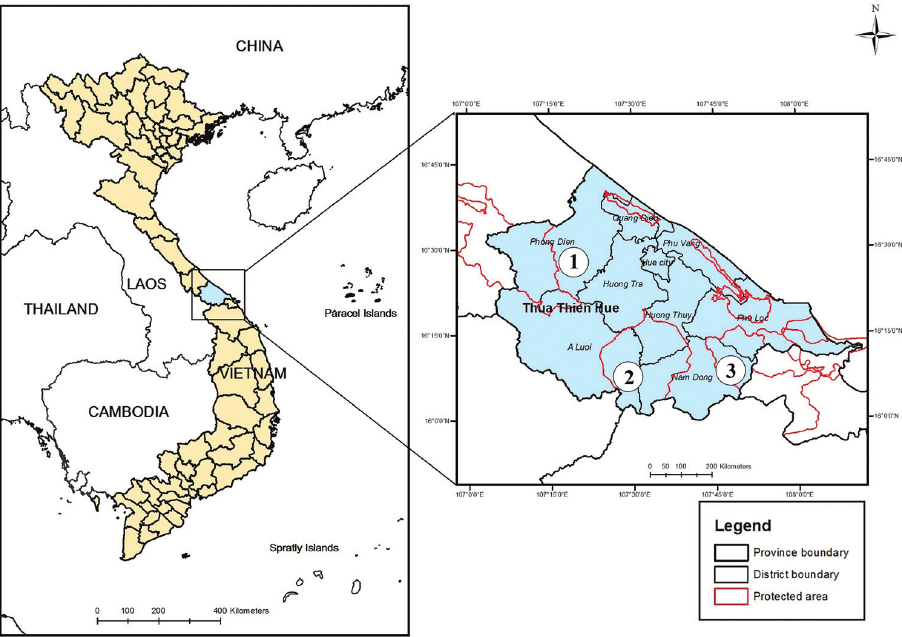
Figure 1. Map of Thua Thien Hue Province in central Vietnam showing the survey sites: 1 Phong Dien NR in Phong Dien District; (2) Sao La NR in A Luoi District; and 3 Bach Ma NP in Nam Dong